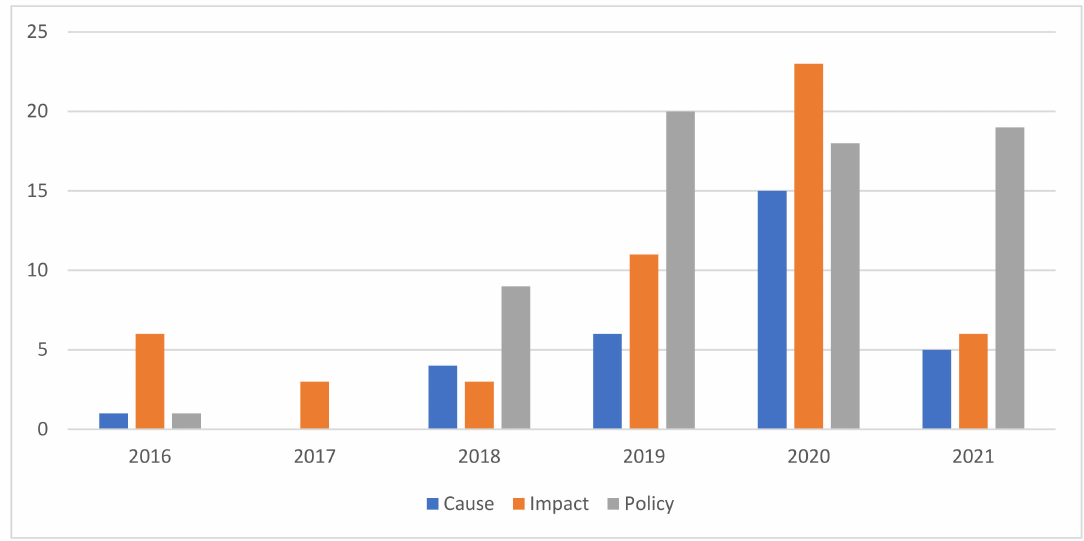
Figure 4. Air pollution publications by Theme per year from 2016–2021. The focus of the thematic air pollution publications indicates that reporting on all three themes was done by Citinewsroom in 2018, 2019, Ghanaian Times in 2019, 2021, Daily Graphic in 2020, Daily Guide in 2020 and Myjoyonline in 2021 (Figure 5).